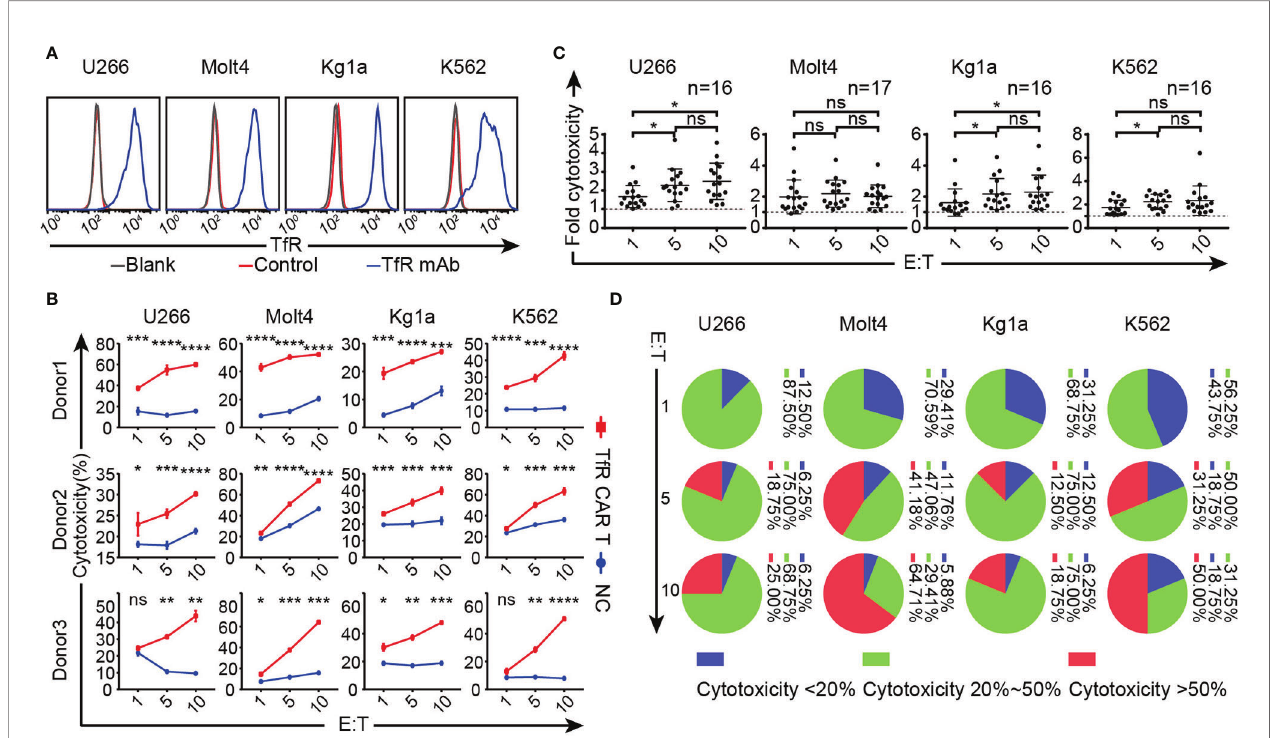
FIGURE 2 | Therapeutic potency of the TfR-CAR T cells to TfR + hematological malignant cells. (A) Expression of TfR on four hematological malignant cell lines. (B – D) TfR-CAR T cells were co-cultured with Tag-it Violet ™ -labeled malignant cells for 20 h at indicated E/T ratio, followed by staining with 7AAD. (B) The percentage of 7AAD + Violet + cells was recorded by FCM to re fl ect cytotoxic activity of T cells. Data from three representative donors are shown. (C) The fold of cytotoxicity of TfR-CAR T/NC T cells. Each dot represented a separate donor. n = 16 – 17. (D) The statistical interval distribution of cytotoxic activity of TfR-CAR T cells prepared from different individuals at indicated E/T ratios. Data are presented as means ± SD (B) or SEM (C) . * P < 0.05, ** P < 0.01, *** P < 0.001, **** P < 0.0001, ns indicates no statistical